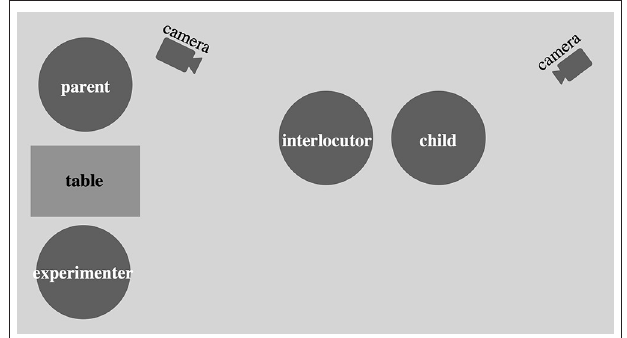
FIGURE 1 | Setup of the study (either the robot or the human served as the interlocutor).